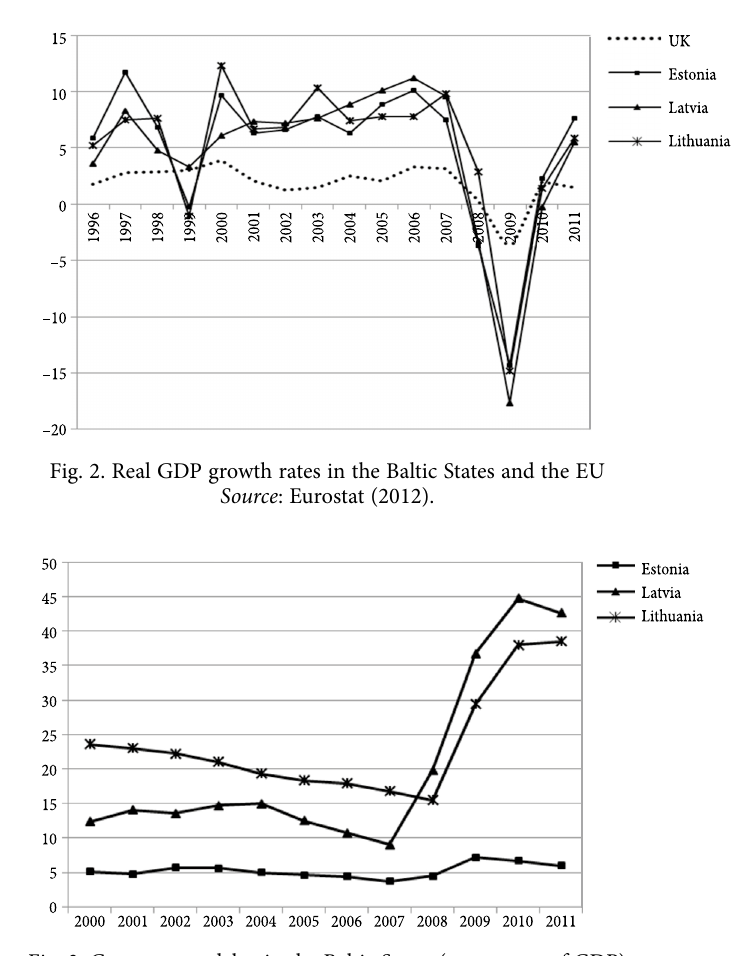
Fig. 3. Government debts in the Baltic States (percentage of GDP) Source : Eurostat